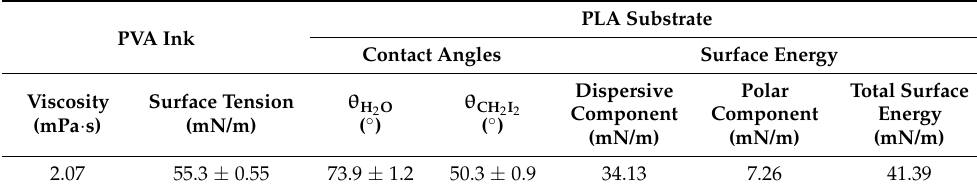
Table 1. Results of PVA ink and PLA substrate characterization as well as images of a pendant drop of PVA ink, water, and diiodomethane sessile drops deposited on PLA substrate.